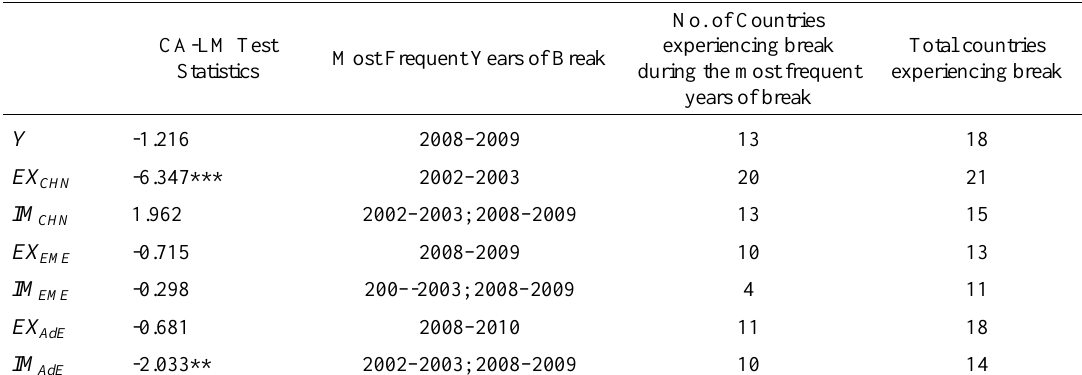
Table 4 : CA-LM unit root